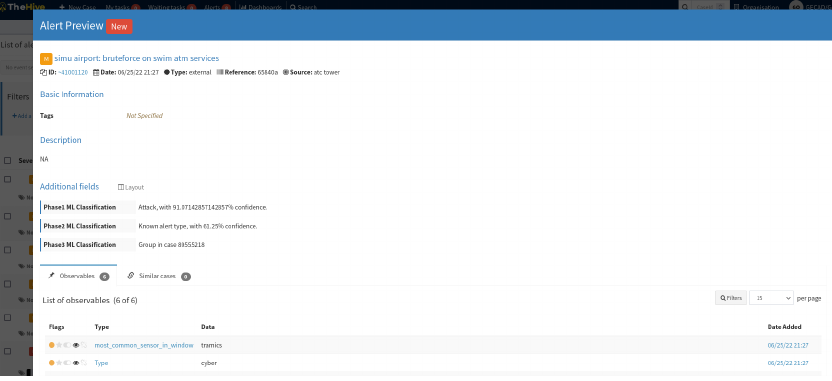
Figure 23. TheHive Alert